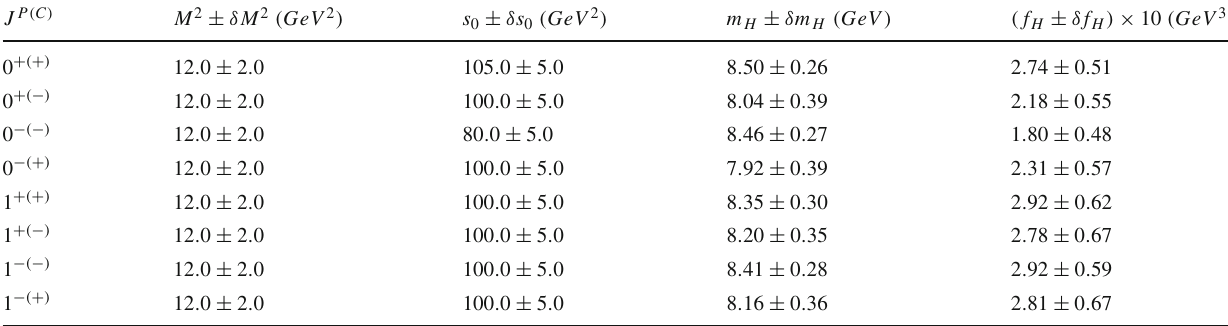
Table 8 Values of the mass and current coupling for different quantum numbers of the ground state bottom-strange hybrid mesons